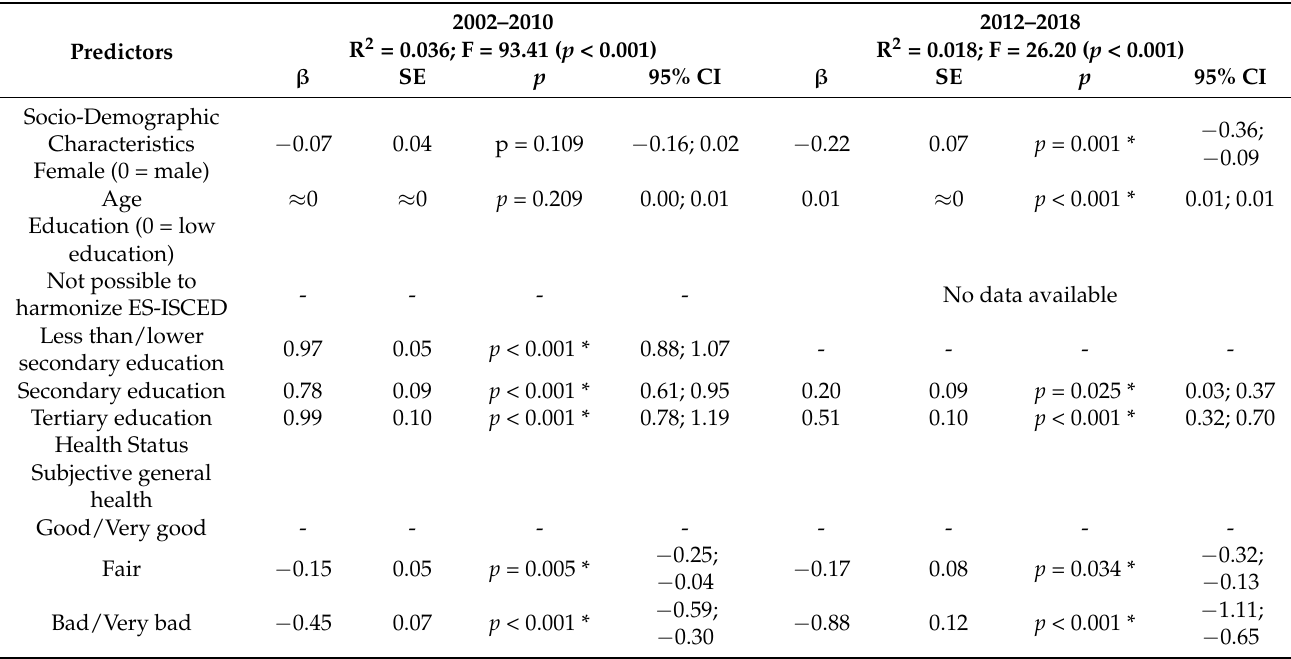
Table 9. Model 5—self-interest.